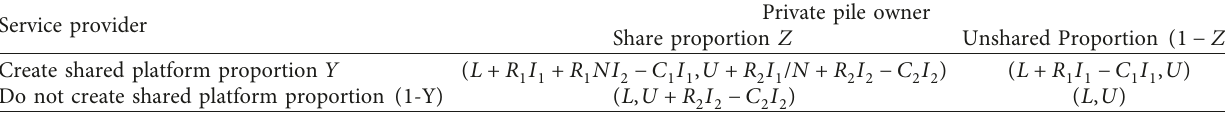
Table 1: Income matrix of operators and private pile